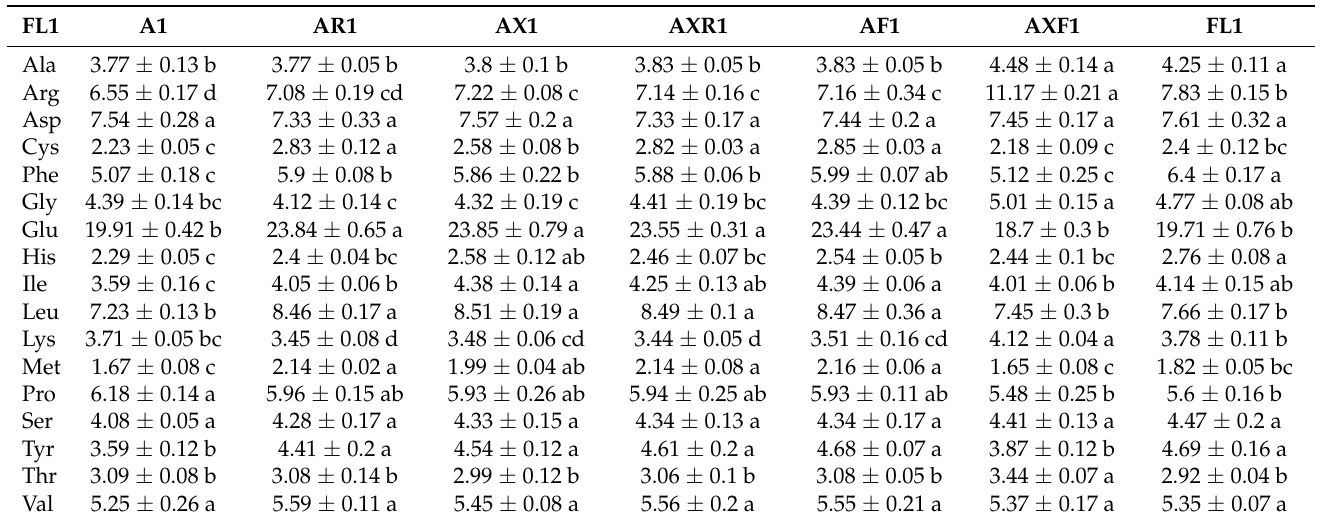
Table 2. The amino acid compositions of oat protein in analyzed samples, with g/100 g of total protein. Means followed by the same letter within a row indicate no significant difference among the samples ( p < 0.05).